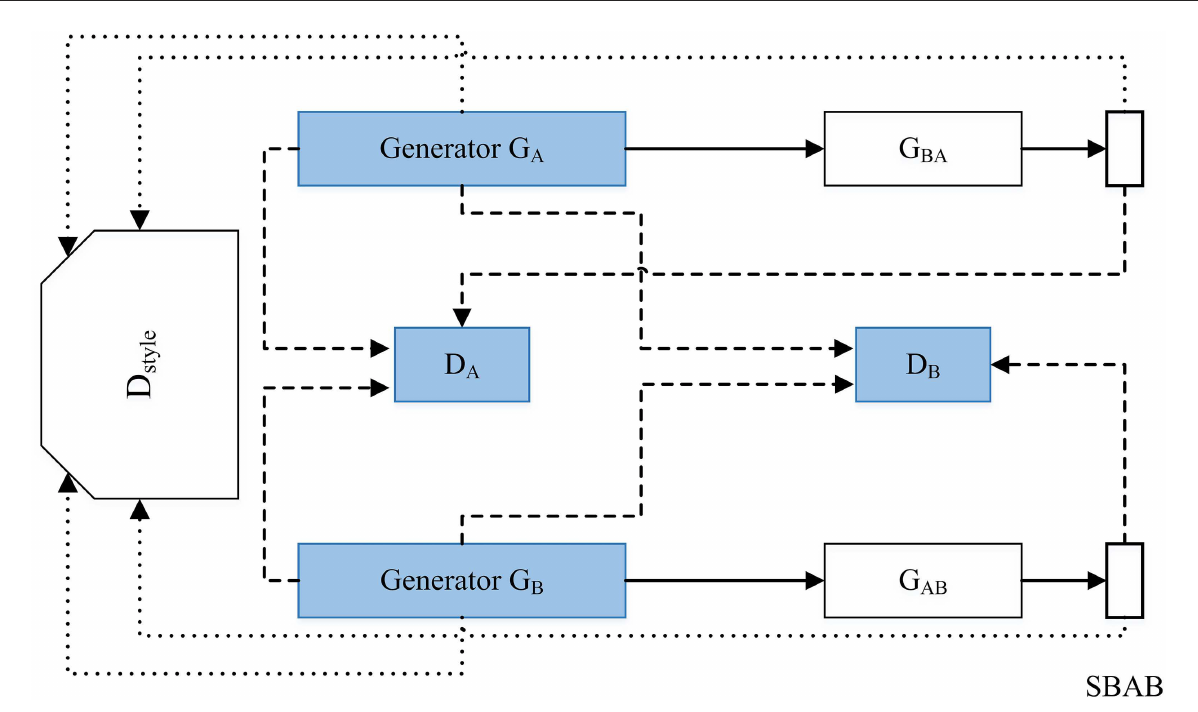
FIGURE9 Impersonation using GAN. The GAN contains 6-layer CNN encoder and transposed6-layer CNN as its generative networks.The discriminative network contains 7-layer CNN with adaptive